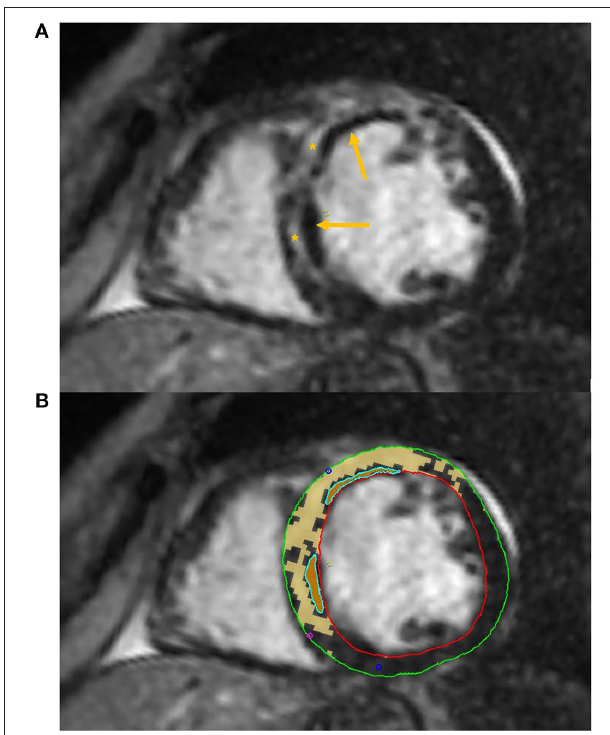
FIGURE 3 | Tissue characterization with Cardiac Magnetic Resonance (CMR). The figure shows an example of tissue characterization in a patient with a history of antero-septal myocardial infarction. (A) Depicts a transmural myocardial scar (asterisks) in the antero-septal region with concomitant evidence of subendocardial areas of microvascular obstruction (MVO, arrows). (B) Shows the automatic identification and quantification of late gadolinium enhancement and the semi-automatic identification of MVO areas on CMR